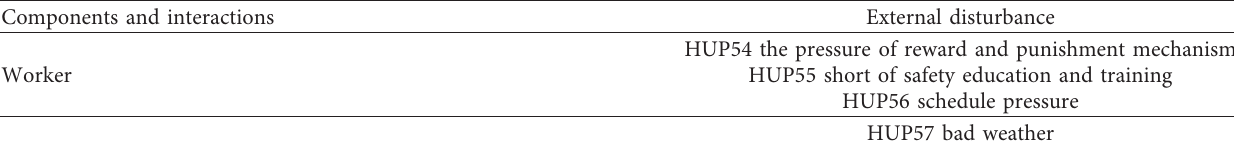
Table 9: External disturbance of usage phase.